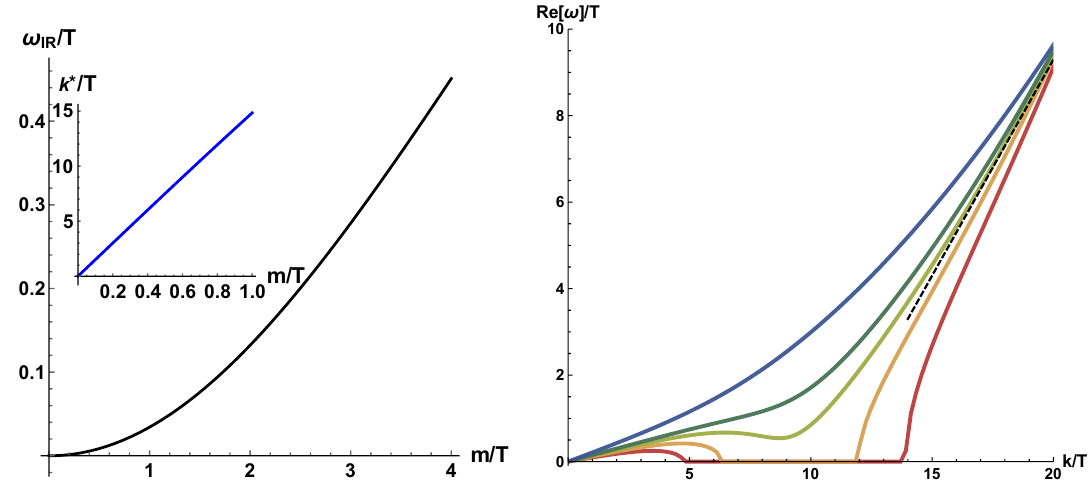
Figure 4 . Left: the Io(cid:11)e-Regel frequency ! IR from eq. (3.9) in function of the dimensionless parameter m=T for the potential V ( X ) = X 5 . The inset shows the momentum k ? at which the real part of the dispersion relation becomes zero accordingly to the hydrodynamic formula (3.2). Right: the dispersion relation of the transverse phonons extended until very large k=T for m=T 2 [0 : 5 ; 1 : 4] (from red to blue) and V ( X ) = X 5 . The dashed line emphasize the ! = k asymptotic